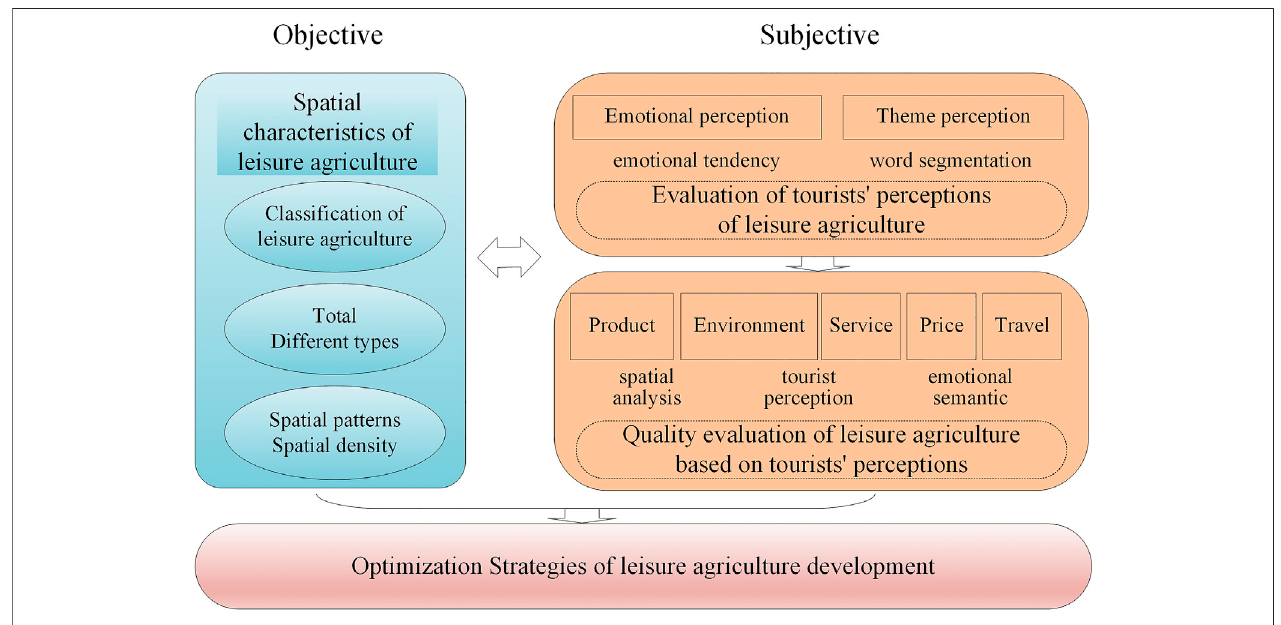
FIGURE 2 | Research